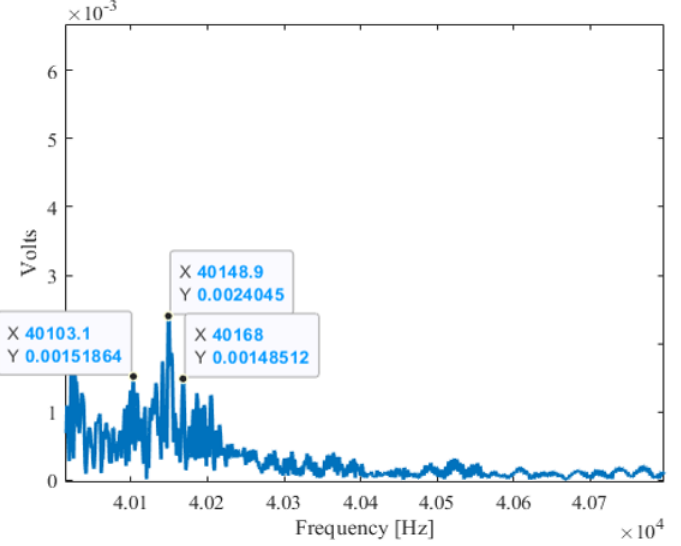
Figure 10. DAQ recording Doppler frequency shift of 3 objects placed at an angle 20 ◦ ,35 ◦ , and 50 ◦ in the time domain.